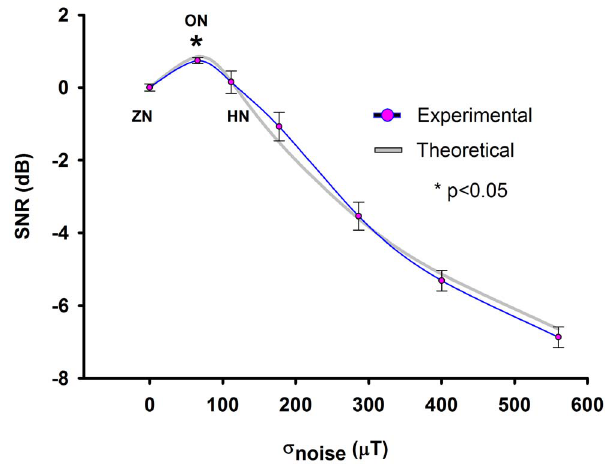
Figure 7. Experimental vs Theoretical SNR. The magenta circles show pooled data from five experiments. The blue line is the signal-to- noise ratio (SNR) computed from our experiments, while the gray line is the theoretical SNR obtained with the Moss-equation (Moss et al., [43– 44]; parameters: A =0.1717; v n =5000; D 0 =10.66). The addition of an optimal noise level increases the SNR and the probability of detecting a subthreshold magnetic signal from the miniature coil. The optimal magnetic noise that improves the capability detection of the MEMS sensor is indicated as ON. Zero noise (ZN), high noise (HN). Values above 100 m T represent HN. The asterisk indicates statistically significant difference for the SNR between optimal noise and zero noise conditions (p , 0.05, Wilcoxon